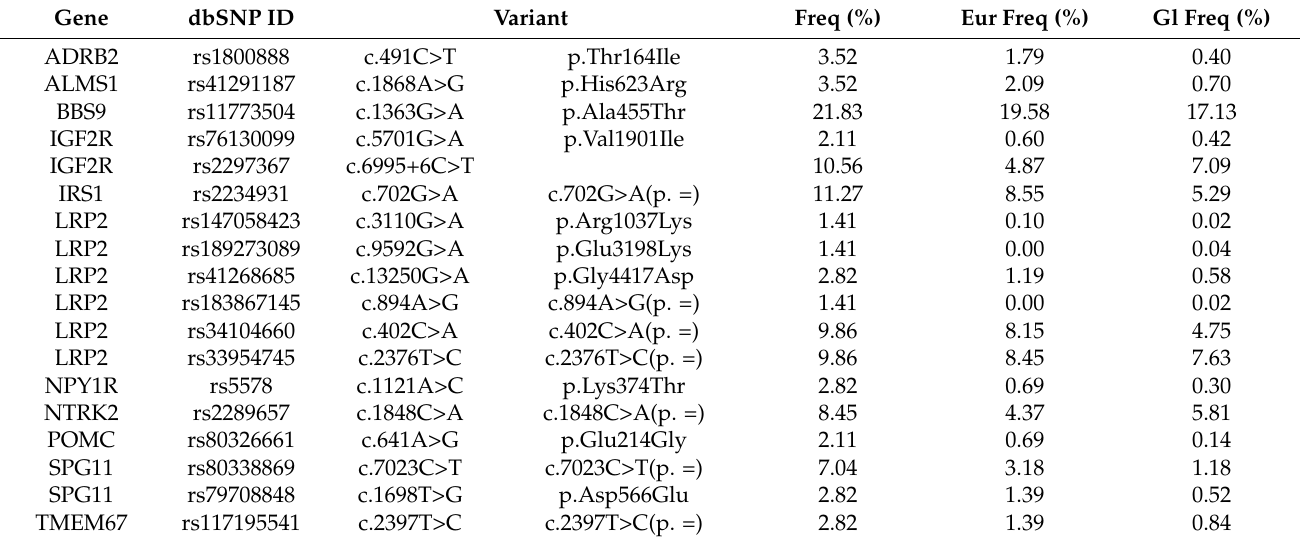
Table 5. Potential risk alleles associated with